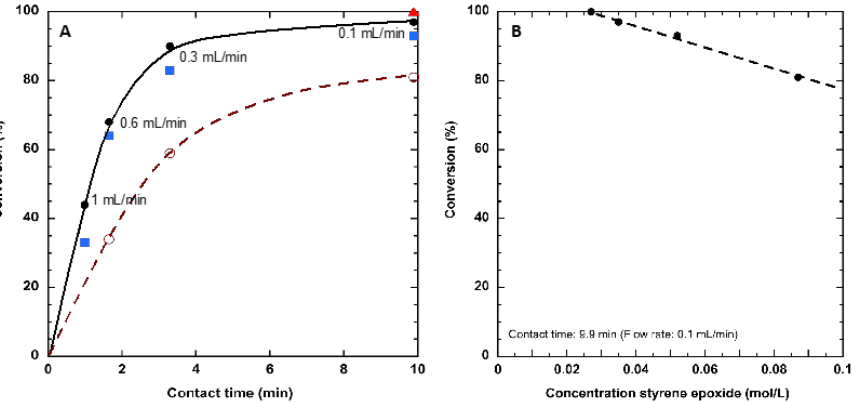
Figure 5. Styrene oxide alcoholysis reaction with CuO@SiO 2 -MN in continuous flow. ( A ) conversion